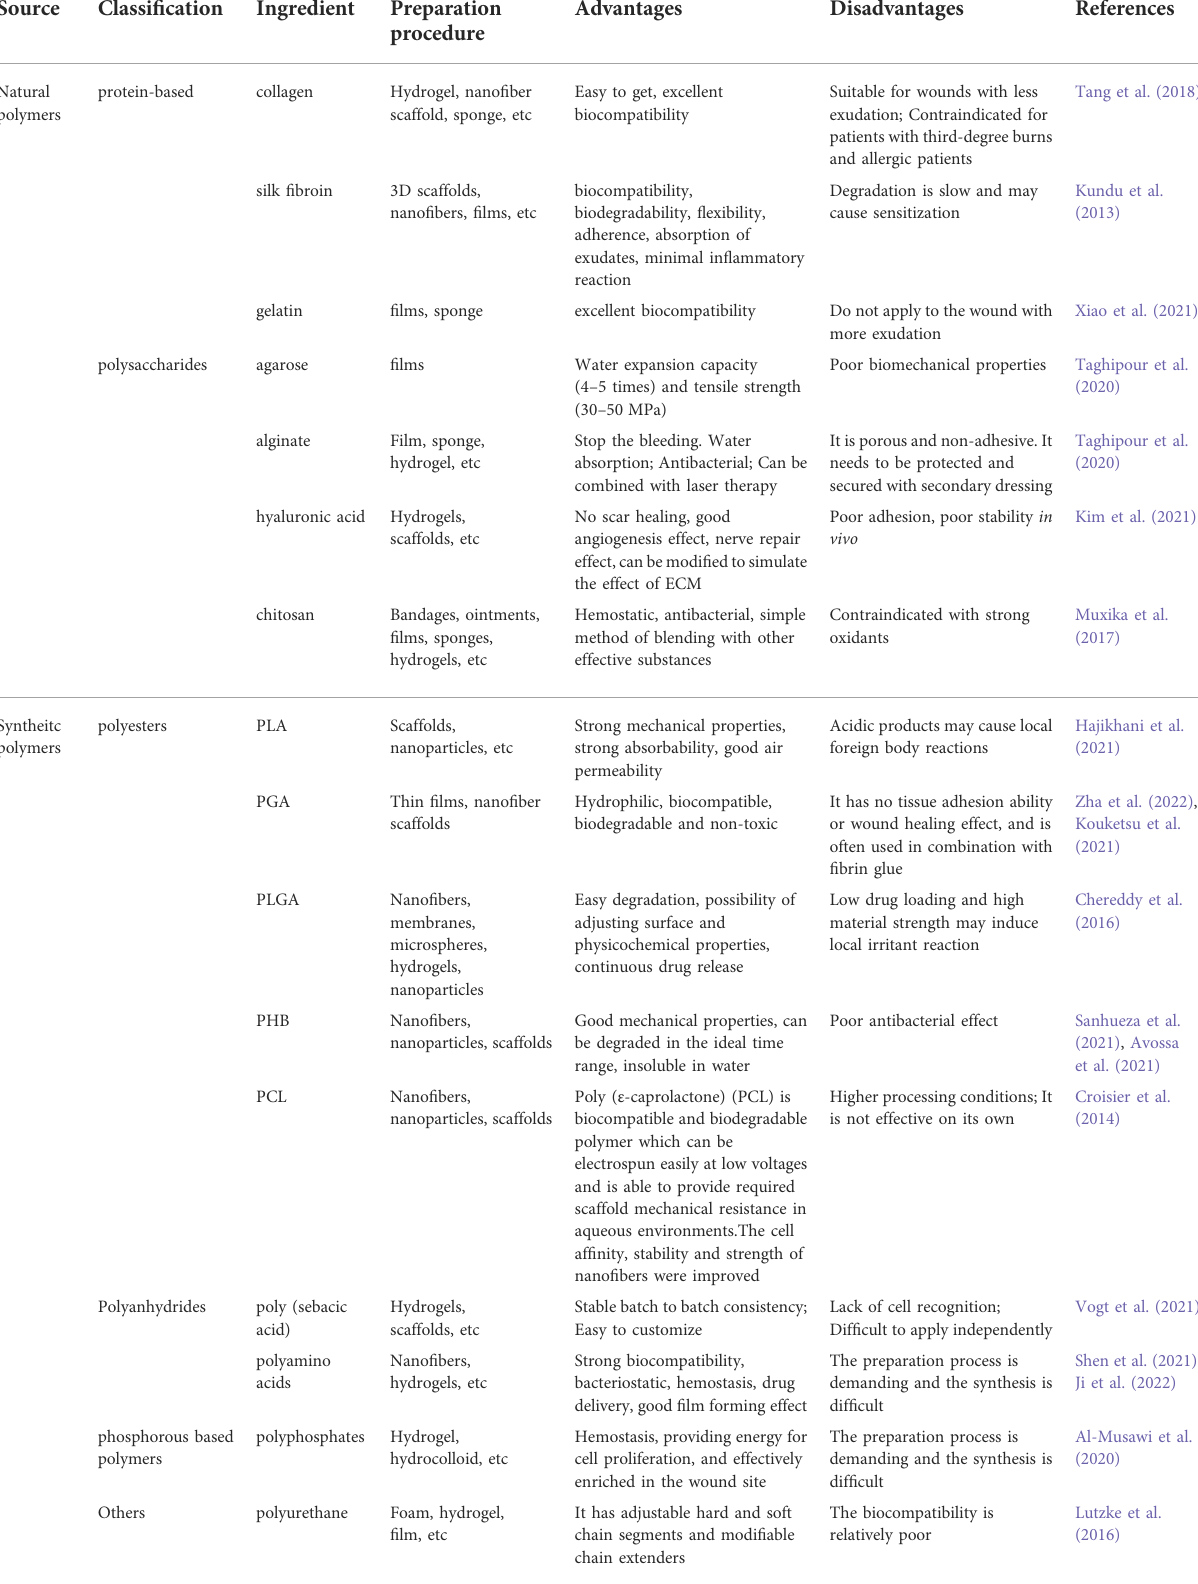
TABLE 1 Classi fi cation and characteristics of